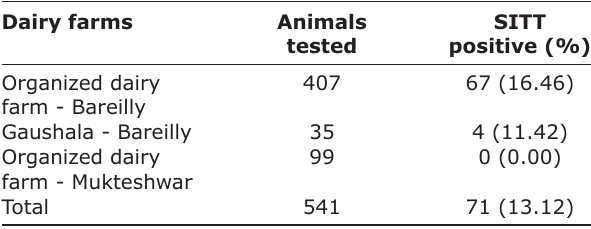
Table-1: List of dairy farms screened through SITT.